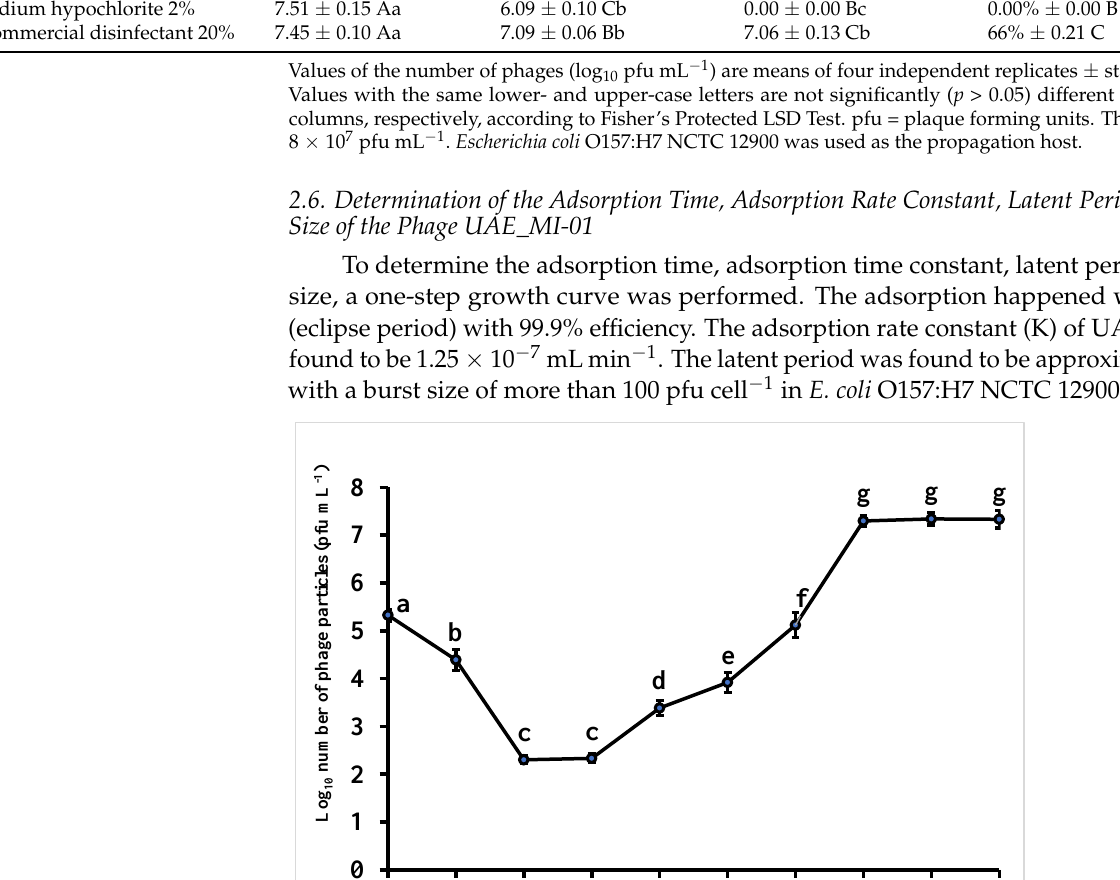
Table 6. Effects of chemical disinfectants on the phage UAE_MI-01.